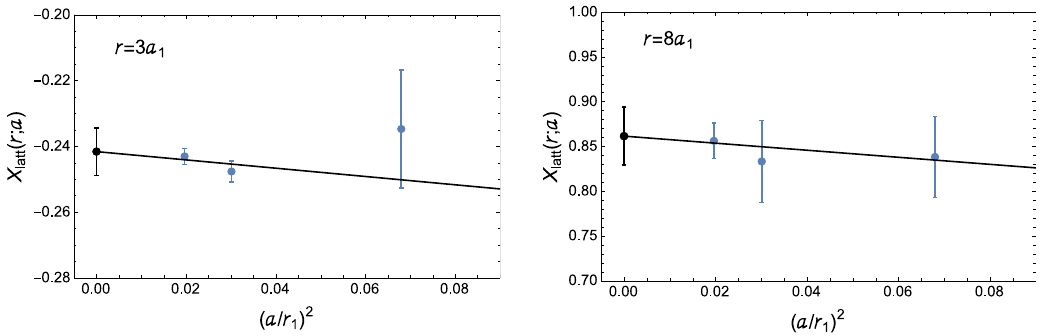
Figure 4 . X latt ( r ; a ) as functions of ( a=r 1 ) 2 . We show them for r = 3 a 1 (left) and r = 8 a 1 (right), which appear in the analysis for d = 1, as examples. Black lines are linear functions in a 2 , which extrapolate the data to the continuum limit. (cid:31) 2 = d : o : f : , which is the reduced (cid:31) 2 in this ex extrapolation, are 1 : 43 (left) and 0 : 15 (right). The black data at a = 0 are the extracted continuum limit with the shown statistical errors.